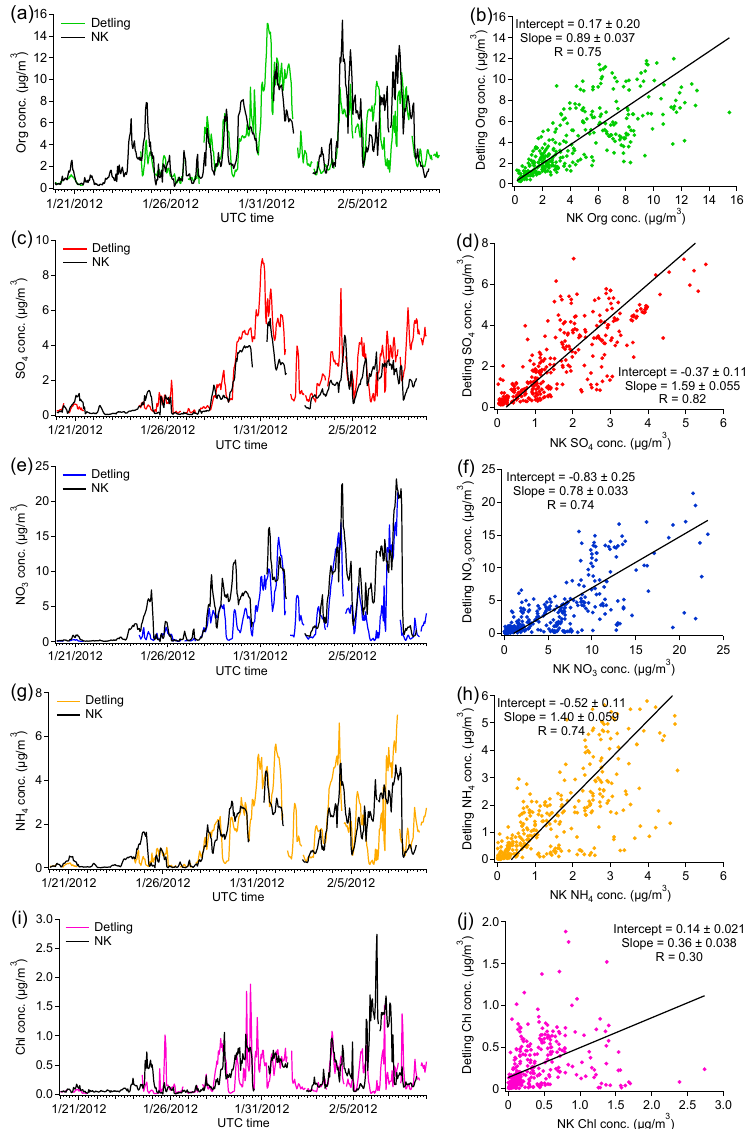
Figure 7. Comparison of non-refractory species time series between NK and Detling sites. The intercept and slope are obtained by orthogonal distance regression. The Pearson’s R is obtained by linear least-squares